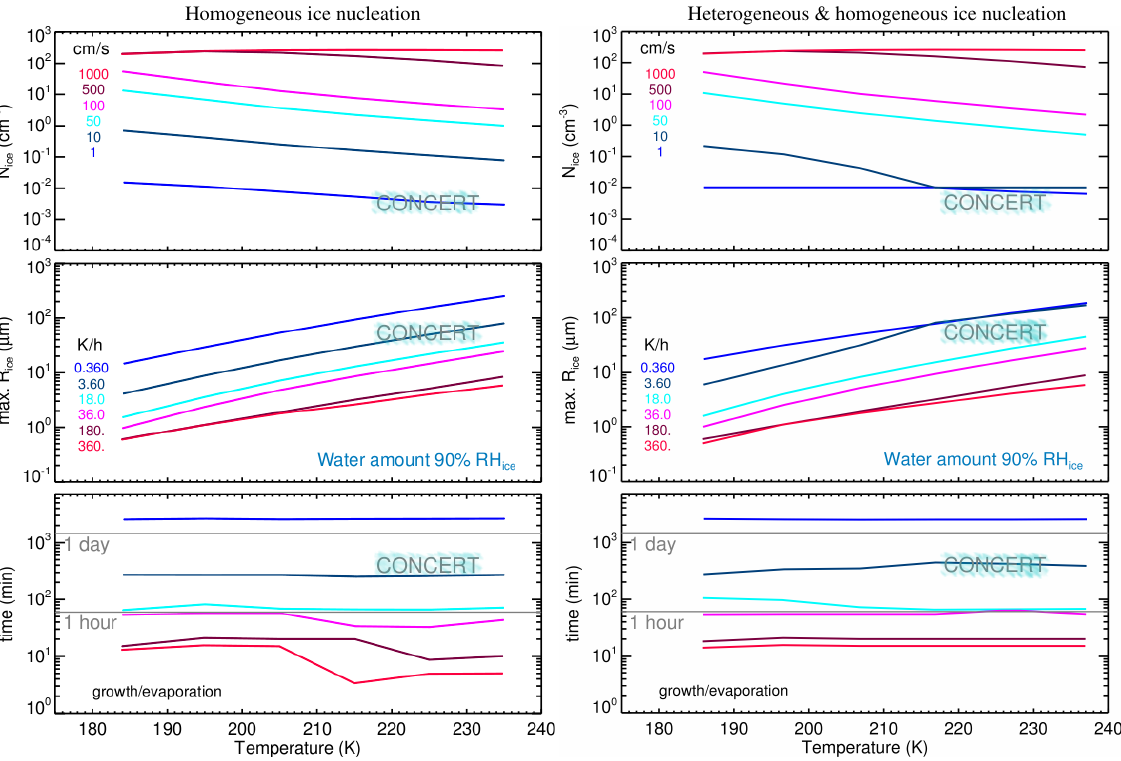
Fig. 12. Ice crystal number (top), maximum size (middle) and growth/evaporation times (bottom) in dependence on temperature and cooling rate ( ∼ vertical velocity): idealized model simulations performed with MAID assuming pure homogeneous (left) and heterogeneous & homogeneous (right) freezing as ice nucleation mechanism. The initial conditions of the model runs are as follows: pressure= f (T ) (Schiller et al., 2008), particle number= 300 cm − 3 , mean particle radius 0.2 µ m. The heating rates during evaporation correspond to the respective cooling rates. The range of observations during CONCERT are indicated in grey letters.